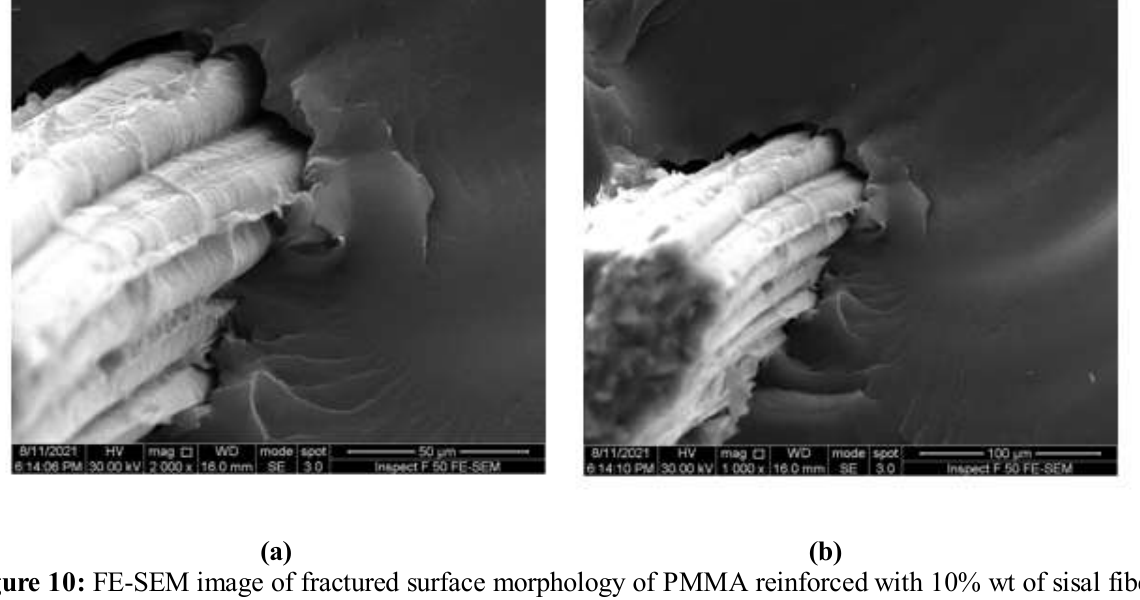
Figure 10: FE-SEM image of fractured surface morphology of PMMA reinforced with 10% wt of sisal fibers with different magnification,(a)FE-SEM magnification 2000x, 50µm, (b) FE-SEM magnification 1000x,